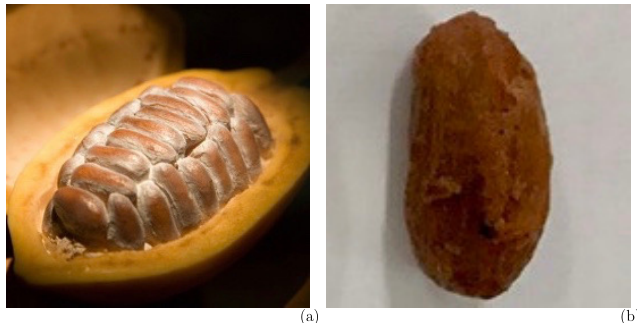
Figure 1. Cocoa fruit ( a ) and fermented Amazonian cocoa bean ( b